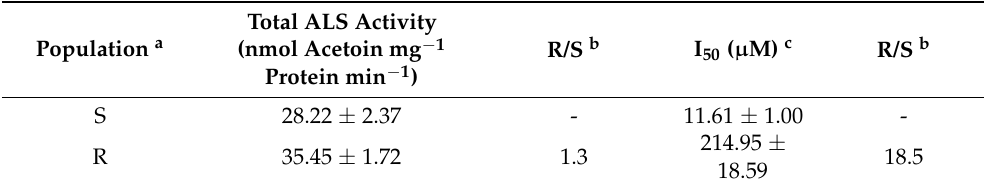
Table 2. In vitro ALS activity of R and S populations of Silene conoidea . The values represent the mean ± SE of two experiments, each containing three replicates.